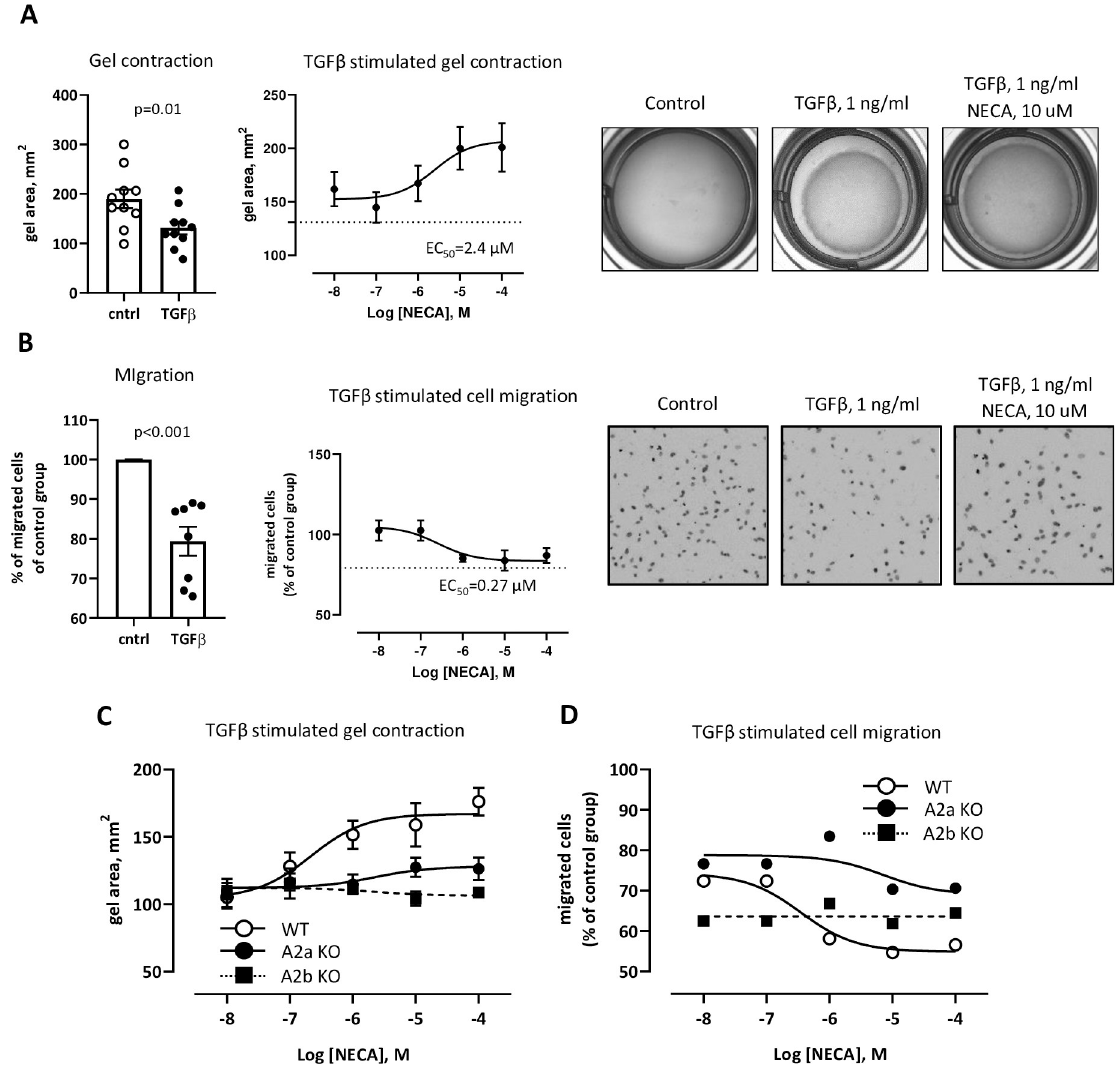
Fig 2. Effect of adenosine on fibroblast migration and gel contraction. A ) Gel contraction assay of mouse mammary fibroblasts. Graphs show gel area, mm 2 . Left plot demonstrates control vs. TGF β . � —p < 0.05 vs. control. Right, logged plot, demonstrates NECA influence on TGF β induced effect. Mouse mammary fibroblasts were embedded to collagen gel and cultured 24 hr. TGF β (1 ng/ml) was added for 6 hr. with following measurement of gel diameter. For dose-dependent experiments NECA (0.01 uM– 100 uM) was added together with TGF β . Dotted line is a TGF β only. B ) Migration assay of mouse mammary fibroblasts. Graphs show % of migrated cells of control group which is used as 100%. Left plot demonstrates control vs. TGF β . � —p < 0.05 vs. control. Right logged plot demonstrates NECA influence on TGF β induced effect. Mouse mammary fibroblasts were placed on the top of 24 wells insert and cultured for 3 hr. in presence of TGF β (1 ng/ml) and NECA (0.01 uM– 100 uM). Dotted line is a TGF β only. C , D ) Logged plots of gel contraction and a migration assays of primary mouse mammary fibroblasts isolated from mouse mammary gland WT and A2a-KO, and A2b-KO animals. Graphs show gel area, mm 2 for gel contraction or % of migrated cell over the control group. TGF β and NECA concentrations are the same as in A and B.